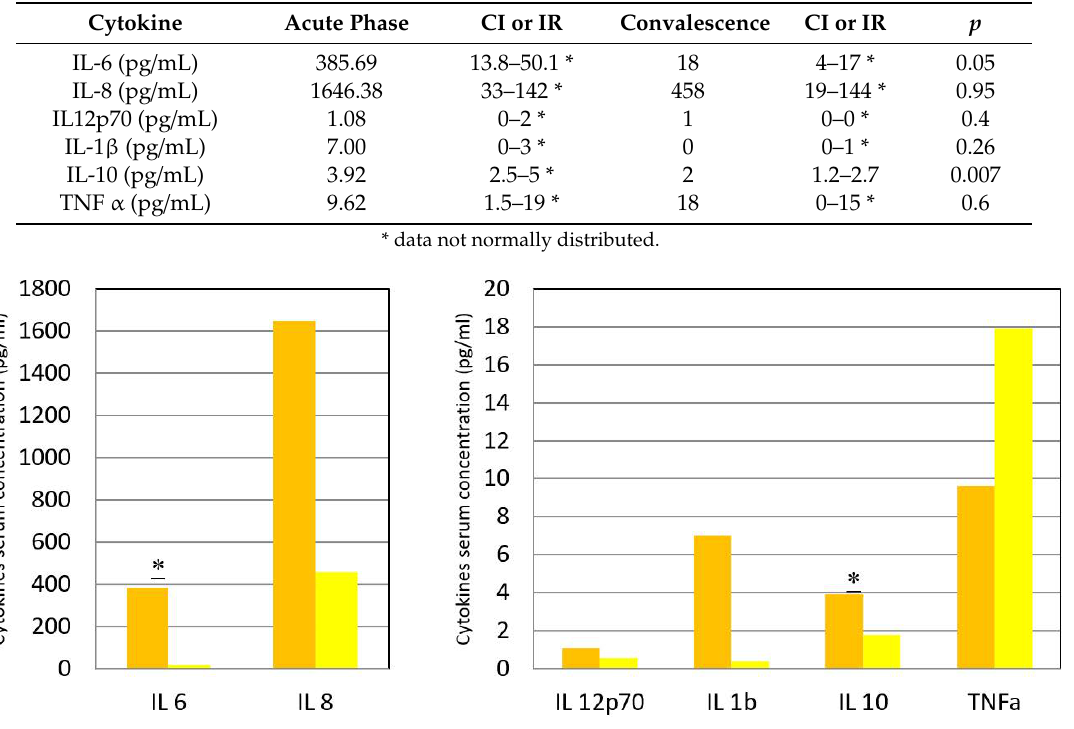
Figure 1. Inflammatory cytokines during the febrile (orange column) and afebrile (yellow column) phases. In ordinates, serum concentration of inflammatory cytokines in pg / mL. Asterisks represent significance at a p = 0.05 for IL-6 and p = 0.007 for IL-10, according to Wilcoxon sign-rank